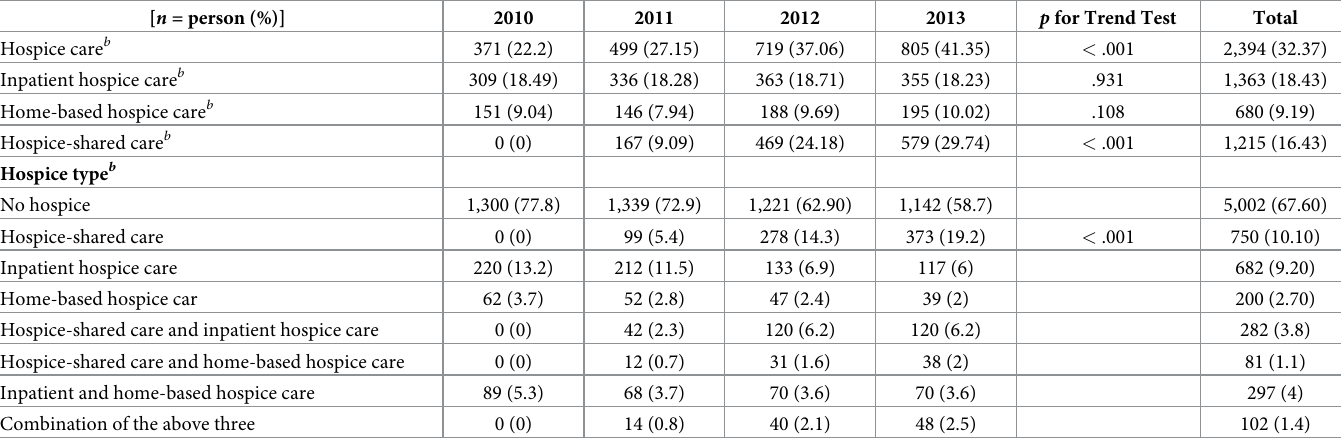
Table 1. Proportions of the different types of hospice care provided to terminal patients a